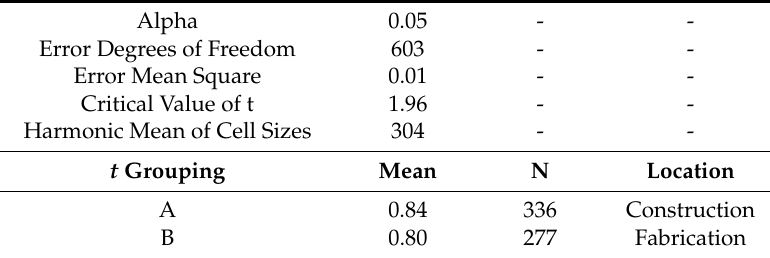
Table 6. t Tests: Least Significant Difference (LSD) for SCS and